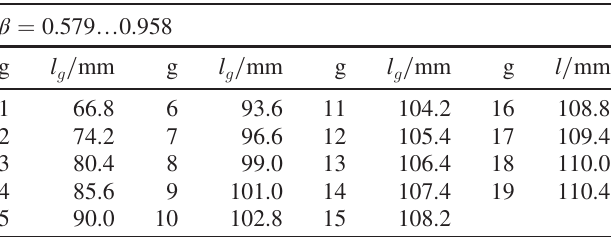
TABLE II. Length l of the cells of the graded- β rf section g MAMBO 1. The lengths are measured from the center of the two neighboring coupling cells. g is the index of the cell. There are 19 ¼ 46 . 7 M Ω , which corresponds to AC and thus 18 CC. R s ¼ 41 kW. P c